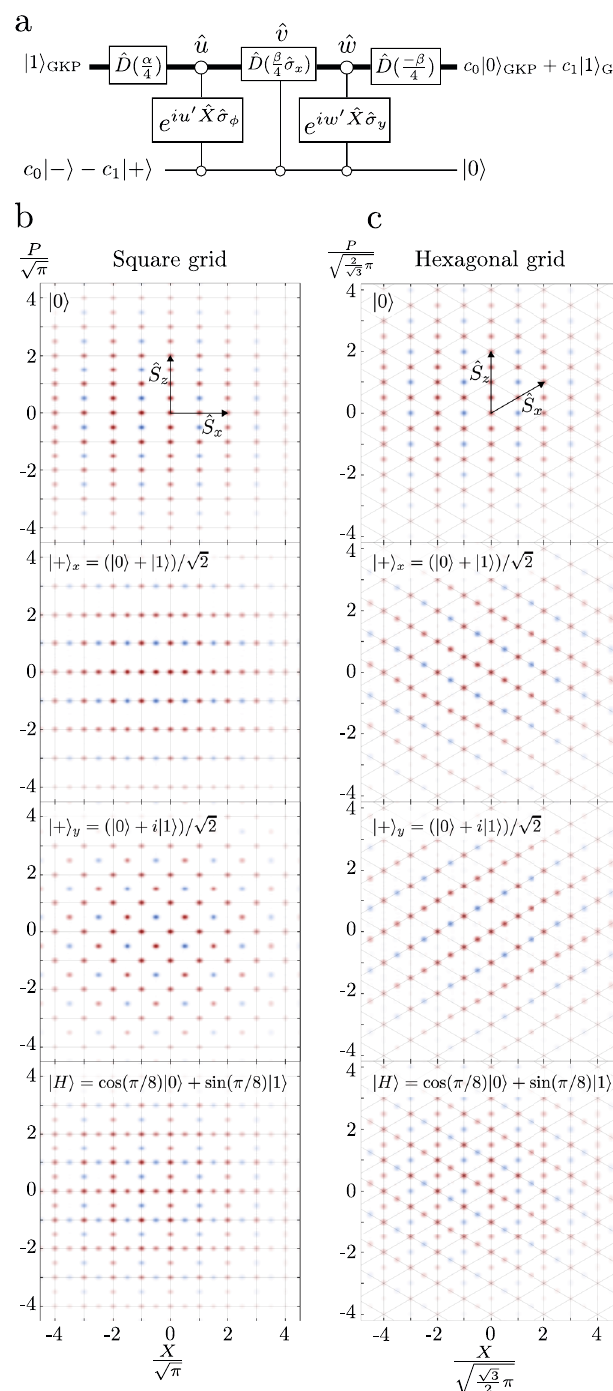
Fig. 3 Preparation of arbitrary logical GKP state. a Circuit diagram for preparing arbitrary logical GKP states. b Wigner functions for various logical square grid states numerically generated using our scheme with N = 3 and 16.6dB input squeezing. c Wigner functions for various logical hexagonal grid states generated using N = 3 and 15 dB input squeezing. The arrows in the top plot of ( b ) and ( c ) show the directions and magnitude of the stabilizer displacements ^ S z and ^ S x